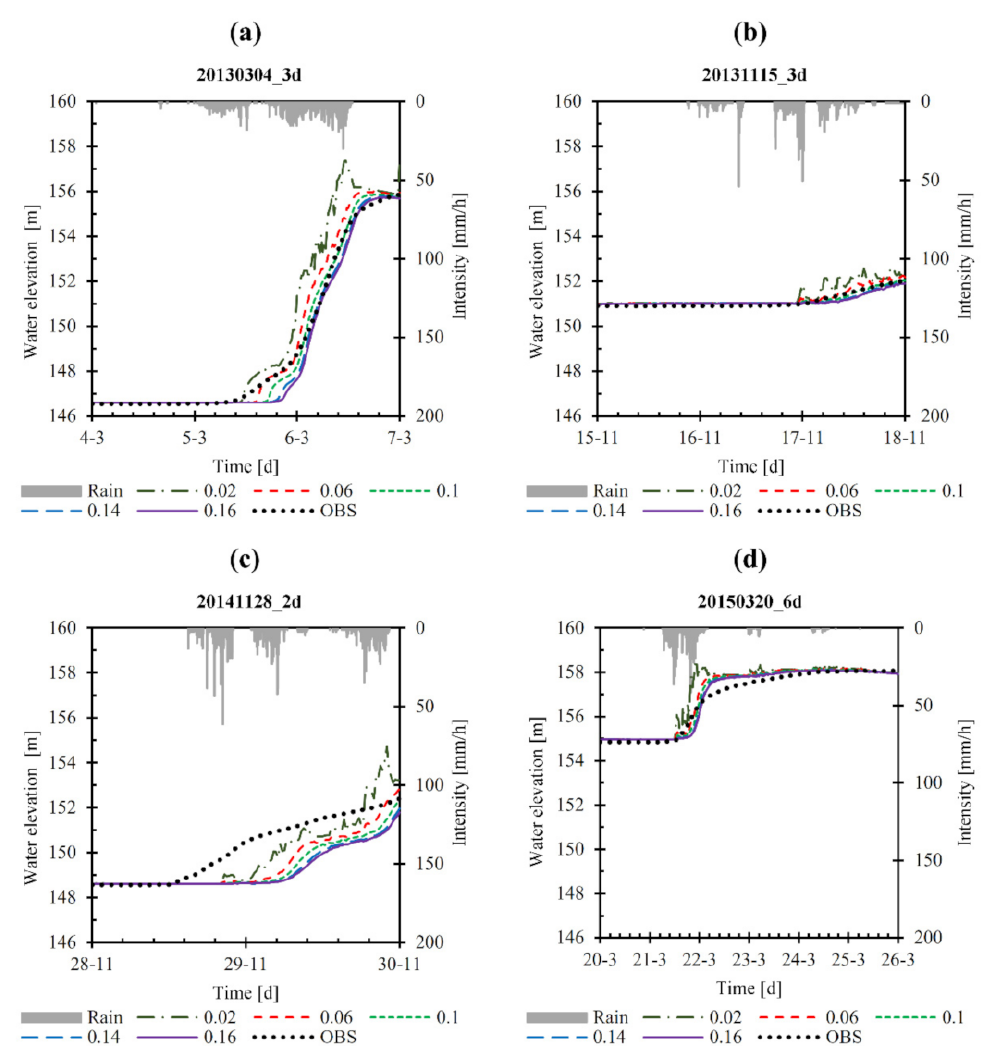
Figure 4. Water elevation evolution in the reservoir for the events 20130304_3d ( a ), 20131115_3d ( b ), 20141128_3d ( c ), and 20150320_6d ( d ). Representation of the observed data (dotted line) and the results of the simulations using different Manning roughness coefficients (coloured